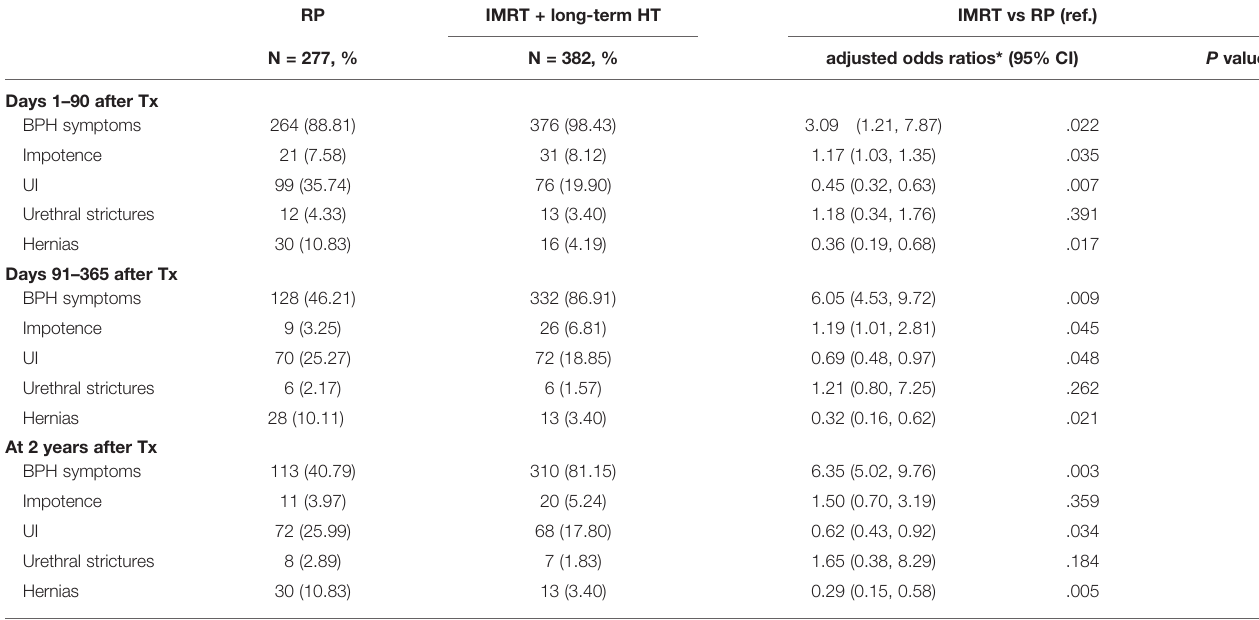
TABLE 1 | Logistic regression analysis of the association of therapeutic modalities with acute and subchronic complications for older men aged ≥ 80 years with high-risk prostate adenocarcinoma. RP IMRT + long-term